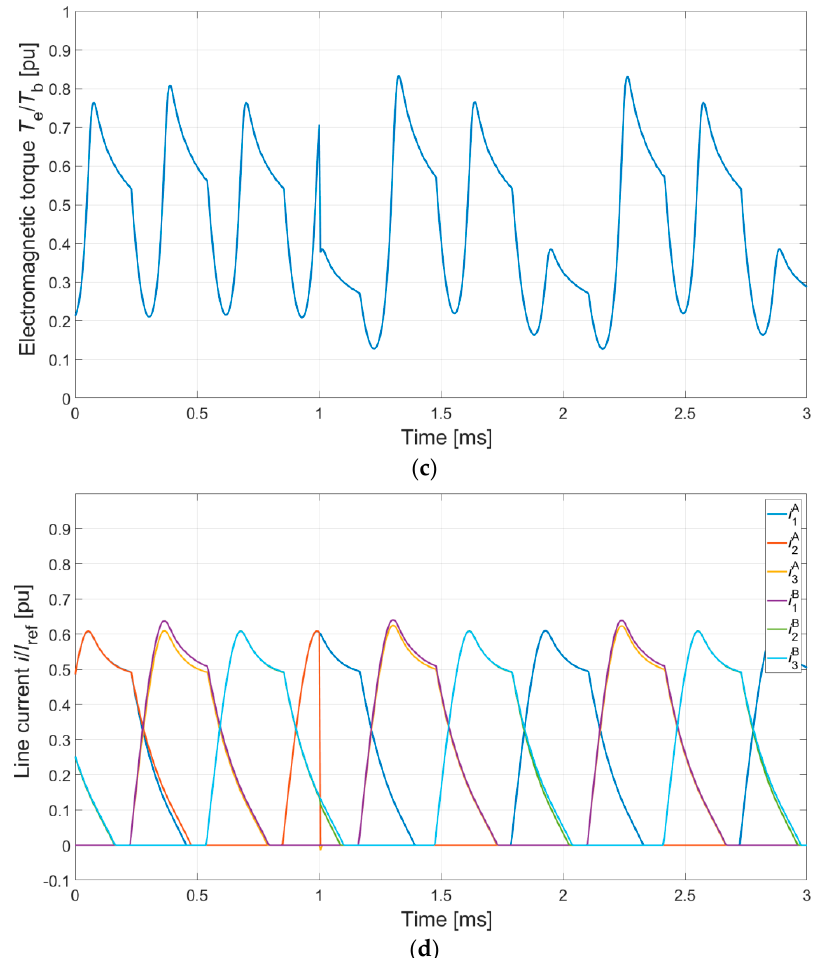
Figure 13. Relative electromagnetic torque and line currents in DCO mode for the DCBLDCM and the DCSRM at open phase in channel B. ( a ) Electromagnetic torque T e for the DCBLDCM. ( b ) Line currents for the DCBLDCM. ( c ) Electromagnetic torque T e for the DCSRM. ( d ) Line currents for the DCSRM.